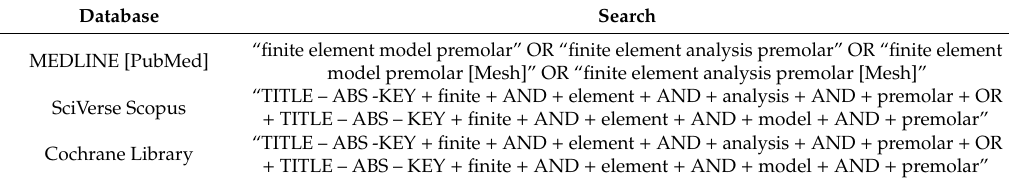
Table 1. Electronic database and search strategy (16 October